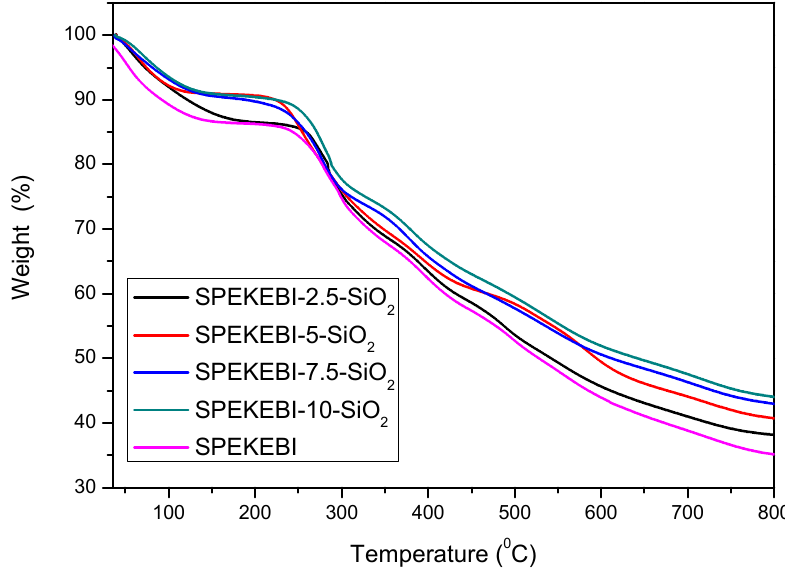
Figure 6. Thermo gravimetric analysis (TGA) diagrams of SPEKEBI-x-SiO 2 and SPEKEBI membranes.